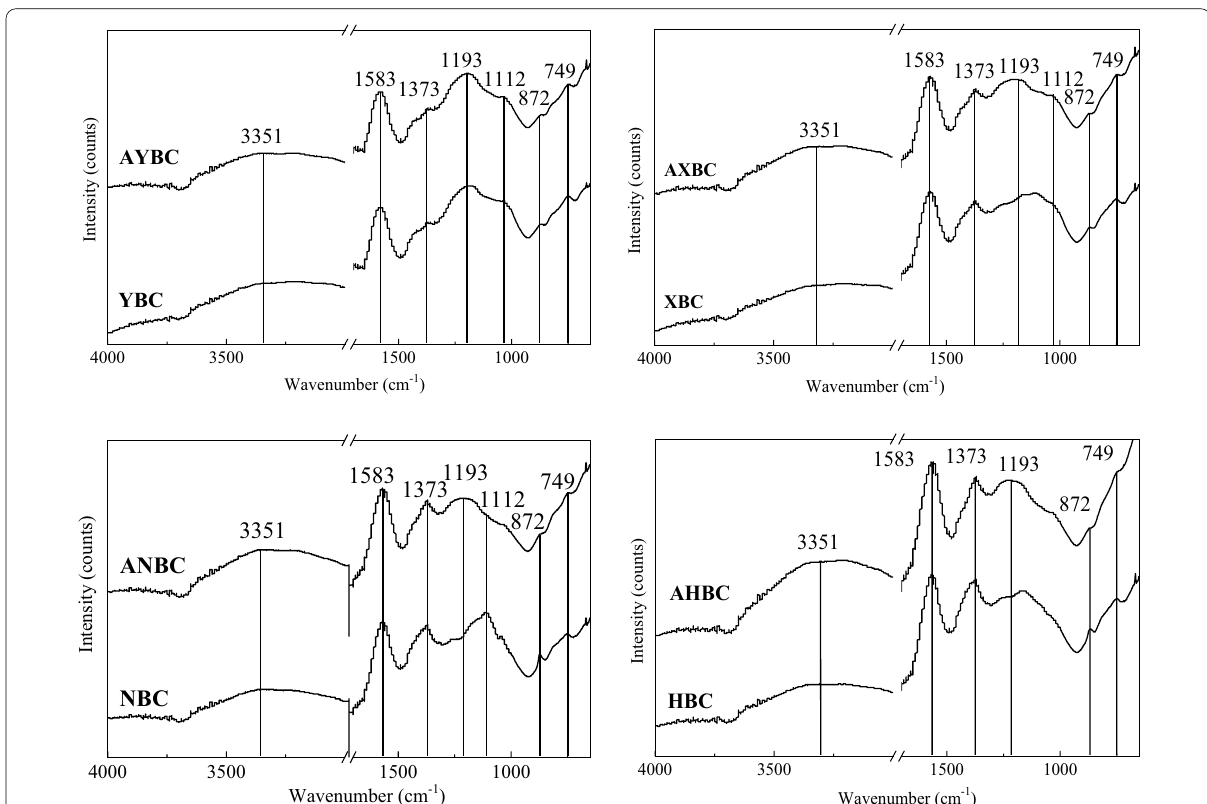
Fig. 2 FTIR spectra of the four pristine canola straw biochars (i.e., YBC, XBC, NBC, and HBC, respectively), relative to their pH-neutralized products (i.e., AYBC, AXBC, ANBC, and AHBC,